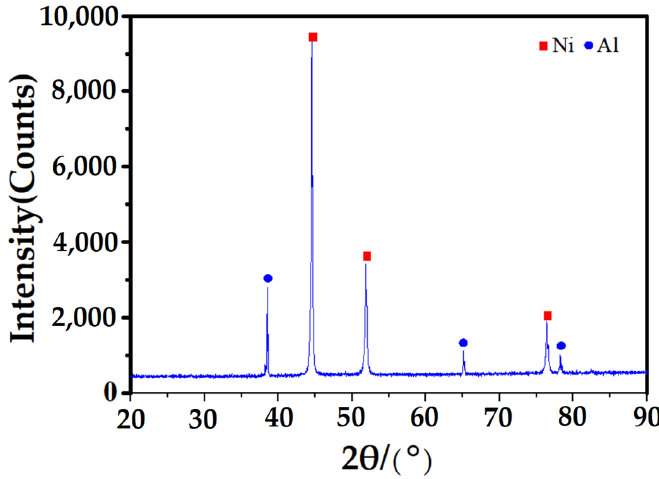
Figure 3. The X-ray diffraction (XRD) patterns of the Ni-coated Al powders